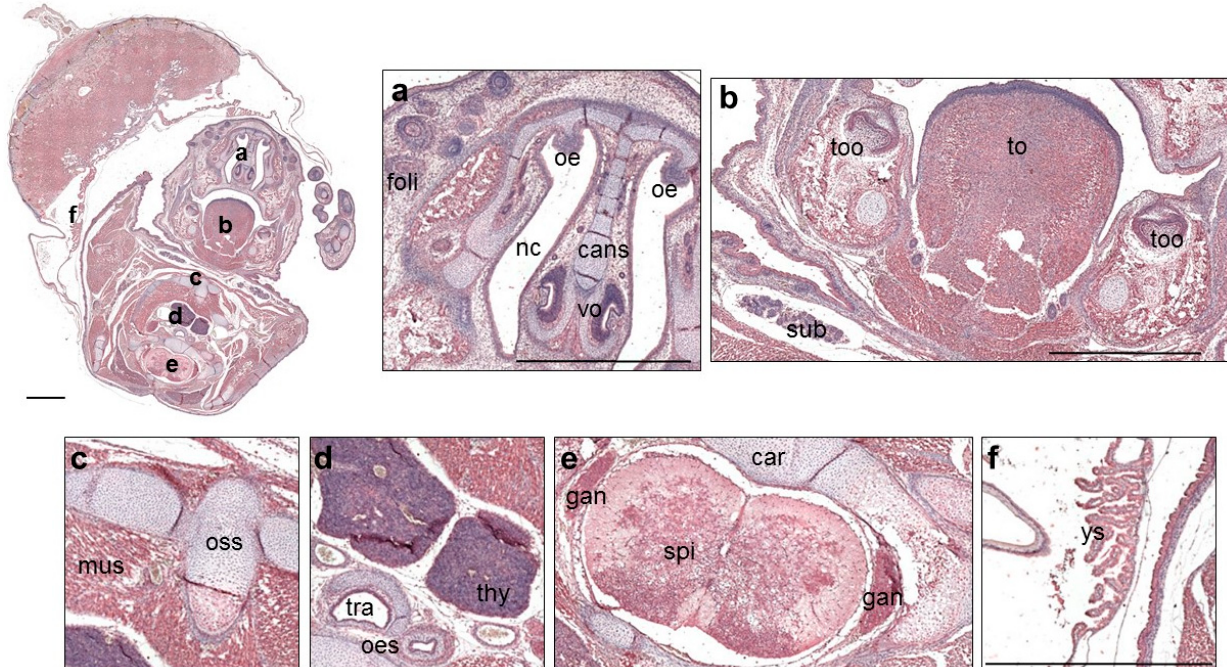
Figure 7. Cellular expression and localization of QSOX1 in tissues of the embryo at 17.5 dpc. The cross-section of the 17.5 dpc embryo is shown on the top left. The detailed QSOX1 cellular distribution is enlarged from six subregions (a to f). ( a ) the nose and vibrissae follicles; ( b ) the tongue and tooth; ( c ) the muscle and sternebrae; ( d ) the thymus, trachea, and esophagus; ( e ) the spinal cord and ganglion; ( f ) uterine muscle, yolk sac, embryo membrane, and skin. Red colors show QSOX1 staining, and blue shows the counterstain of hematoxylin in the nucleus. Scale bar = 1 mm. Abbreviations: cans, cartilage primordium of the nasal septum; car, cartilage; foli, follicles of vibrissae; gan, ganglion; mus, muscle; nc, nasal cavity; oe, olfactory epithelium; oes, esophagus; oss, ossification with sternebrae; spi, spinal cord; sub, submandibular gland; thy, thymus; to, tongue; too, tooth; tra, trachea; vo, vomeronasal organ; ys, yolk